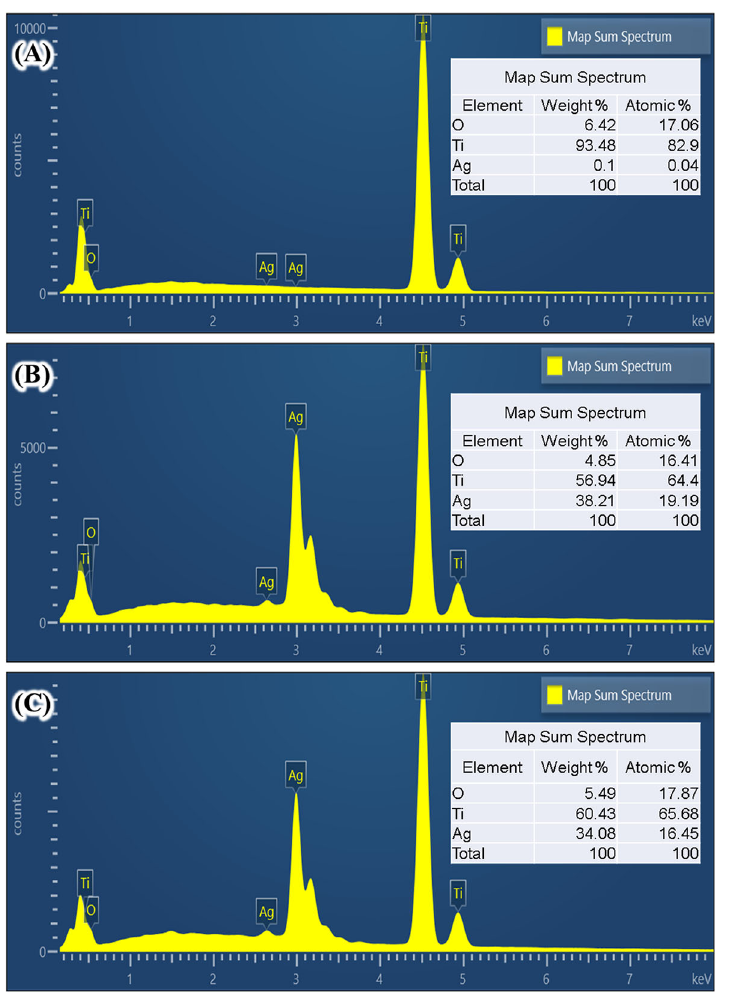
Figure 5. Element composition of untreated Ti (A), Ag coated Ti from 0.01 mol/L AgNO 3 (B), and Ag coated Ti from 0.1 mol/L AgNO 3 (C) obtained from energy dispersive X-ray analysis. 14